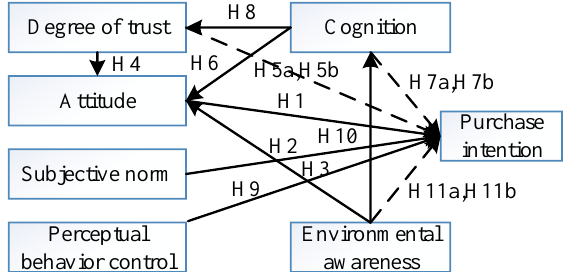
Figure 4. Purchase Intention Model of Organic Agricultural Products.